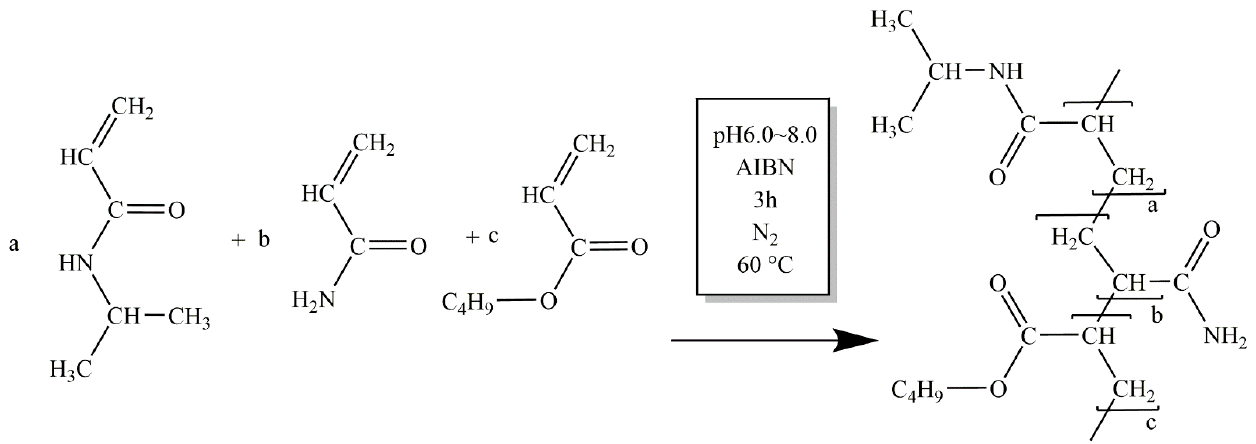
Figure 13. Chemical structure of PNBAM.